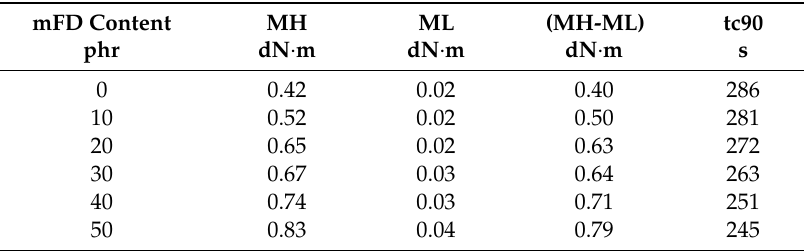
Table 3. Vulcanization parameters of the mFD / natural rubber